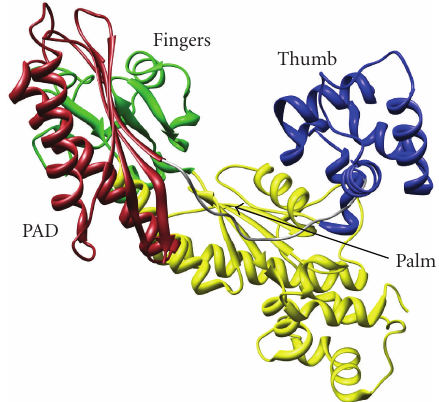
Figure 6: Structural overview of the TLS yeast polymerase eta (PDB# 1JIH, molecule A) [41]. γ Pol η contains stubby fingers (green), and thumb (blue) domains, a palm (yellow) domain, as well as a polymerase associated domain (PAD) (brown). The open nature of the active site allows two nucleotides to be accommodated during synthesis, as well as bulky carcinogenic adducts and DNA distorting